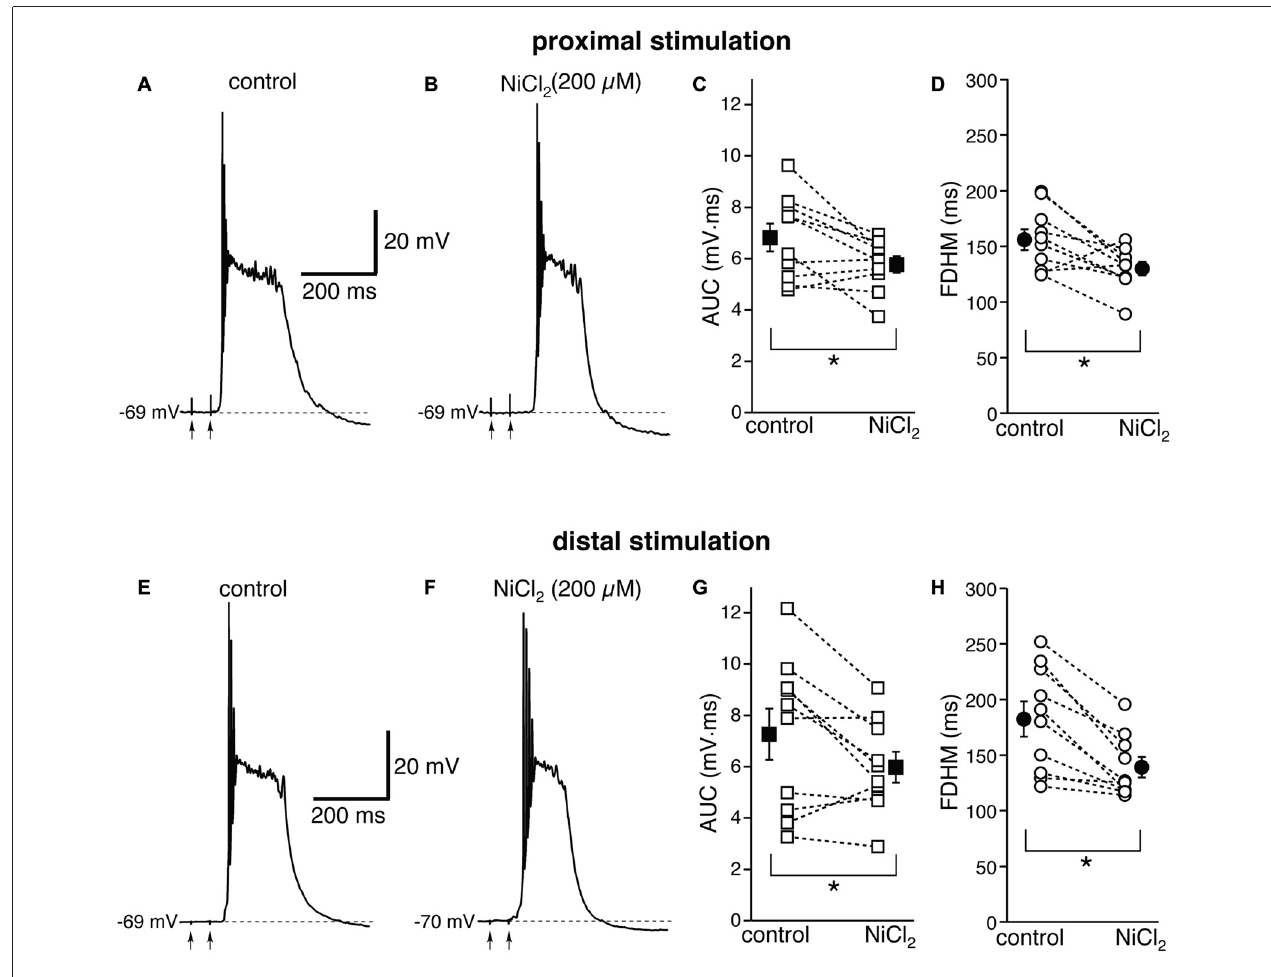
FIGURE 5 | NiCl 2 , at a concentration that blocks both R- and T-type Ca 2 + channels, reduces the depolarizing plateaus and bursts at proximal and distal synapses. Top, representative trace of a burst recorded upon stimulation of proximal afferent fibers in control conditions (A) and in the presence of NiCl 2 (200 µ M, B ). NiCl 2 reduced the AUC (C) by 13 ± 6% and the FDHM (D) 15 ± 6% in n = 10 neurons. Bottom, representative trace of a burst recorded upon stimulation of distal afferent fibers in control conditions (E) and in the presence of NiCl 2 (F) . NiCl 2 reduced the AUC (G) by 22 ± 4% and the FDHM (H) by 12 ± 8% in n = 10 neurons. Asterisks indicate significant difference between control and NiCl 2 treatment. There was no statistically significant interaction between the NiCl 2 treatment and location (two-way mixed ANOVA). The traces in (A,B) and (E,F) were recorded from two separate neurons.